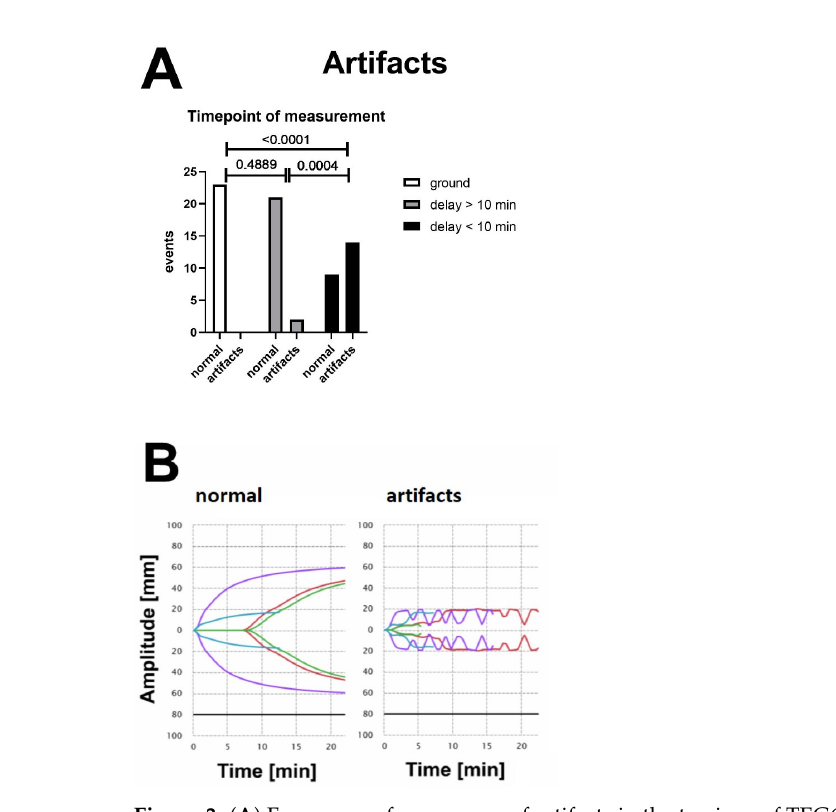
Figure 3. ( A ) Frequency of occurrence of artifacts in the tracings of TEG6s measurements. Unlabelled curves were inspected by an operator, who was blinded to the experiment. Data were then stratified by the time from beginning of measurement until the engine was started (“delay < 10 min vs. >10 min”). No artifacts were found in any of the ground measurements. When the measurement was started within 10 min prior to starting the engine, a high number of artifacts were present. In case a certain clot firmness was reached when the engine was started (delay > 10 min), susceptibility of the measurement to artifacts was reduced. Depicted p ‐ values are derived from the applied Chi ‐ square test ( B ). Representative tracings of measurements on the ground and in ‐ flight (engine on). Multiple inflections and artifacts are visible in measurements that were started immediately (delay < 10 min). 2.3. Vibratometric Measurements Magnitude and timing of vibrations were quantified with a mobile vibrometer appli ‐ cation for iPhone IOS (Apple Inc., Cupertino, CA, USA), using accelerometric data. The device (iPhone 5, Apple Inc., Cupertino, CA, USA) was fixed directly to the aircraft floor and was aligned to the two TEG6s devices (directions and axes are illustrated in the Figure 4 insert). The devices were placed in the helicopter in a way that the Y ‐ axis corresponds